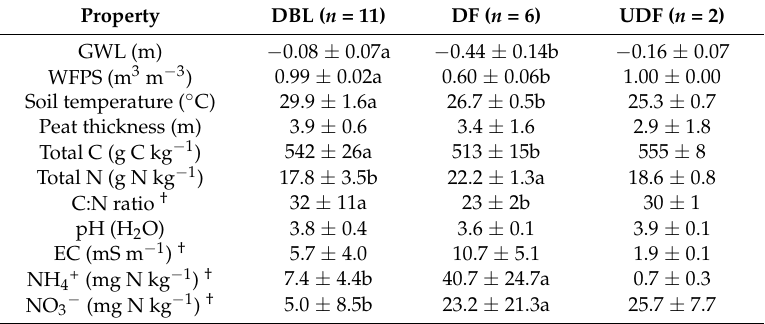
Table 1. Soil properties in DBL (drained burned land), DF (drained forest), and UDF (undrained forest). Values show mean ± 1 standard deviation, and the same letters beside the values denote no significant difference between DBL and DF ( p <